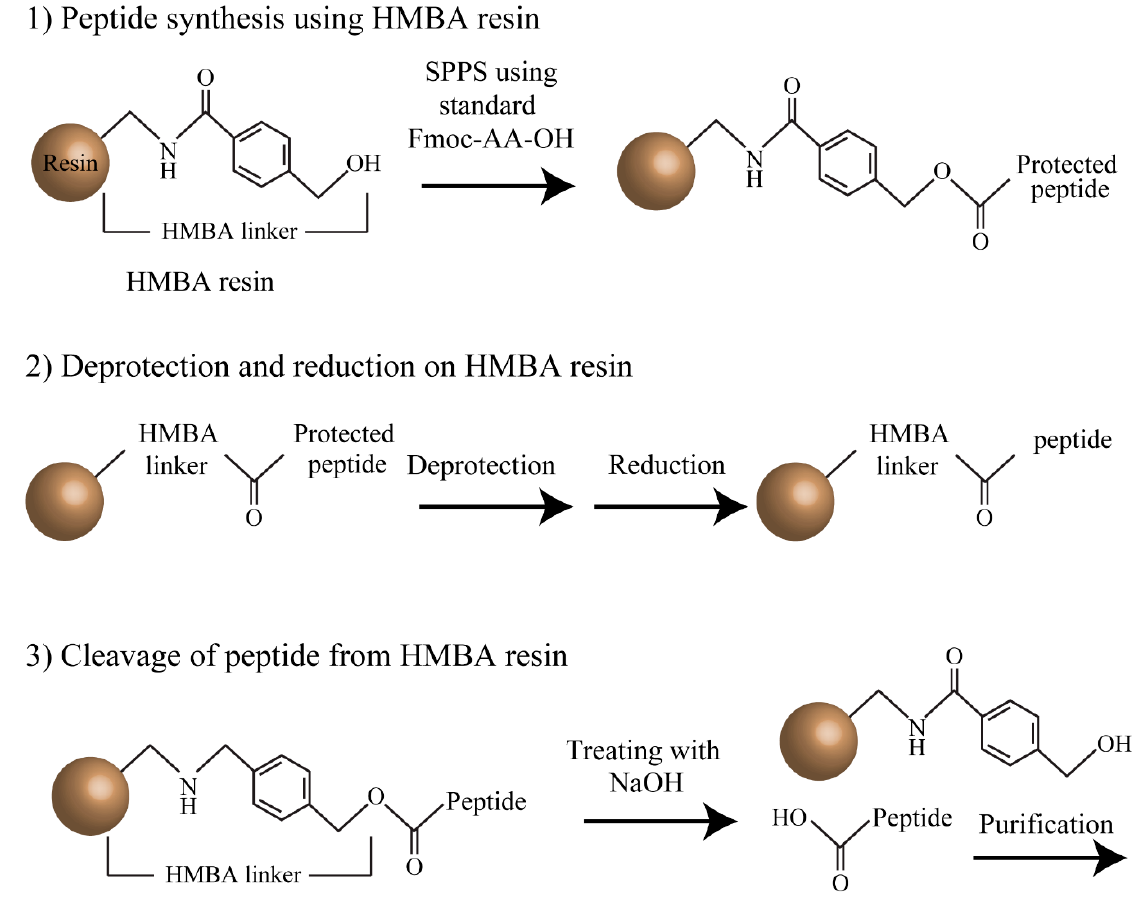
Figure 1. Scheme of the peptide synthesis, deprotection, reduction, cleavage, and purification process. 1 ) After attaching the first amino acid to 4-hydroxymethyl benzamide (HMBA) resin by standard ester coupling, standard Fmoc peptide synthesis was conducted using the (HBTU)–1-hydroxy benzotriazole monohydrate (HOBt) method. 2 ) Deprotection of all of the side-chain-protected peptide was conducted using the standard trifluoroacetic acid (TFA) method. Then some oxidized peptides were reduced using NH 4 I and dimethyl sulfide (DMS). 3 ) Cleavage of the peptide from HMBA resin using 500 mM NaOH and acetonitrile (1/1, v/v).